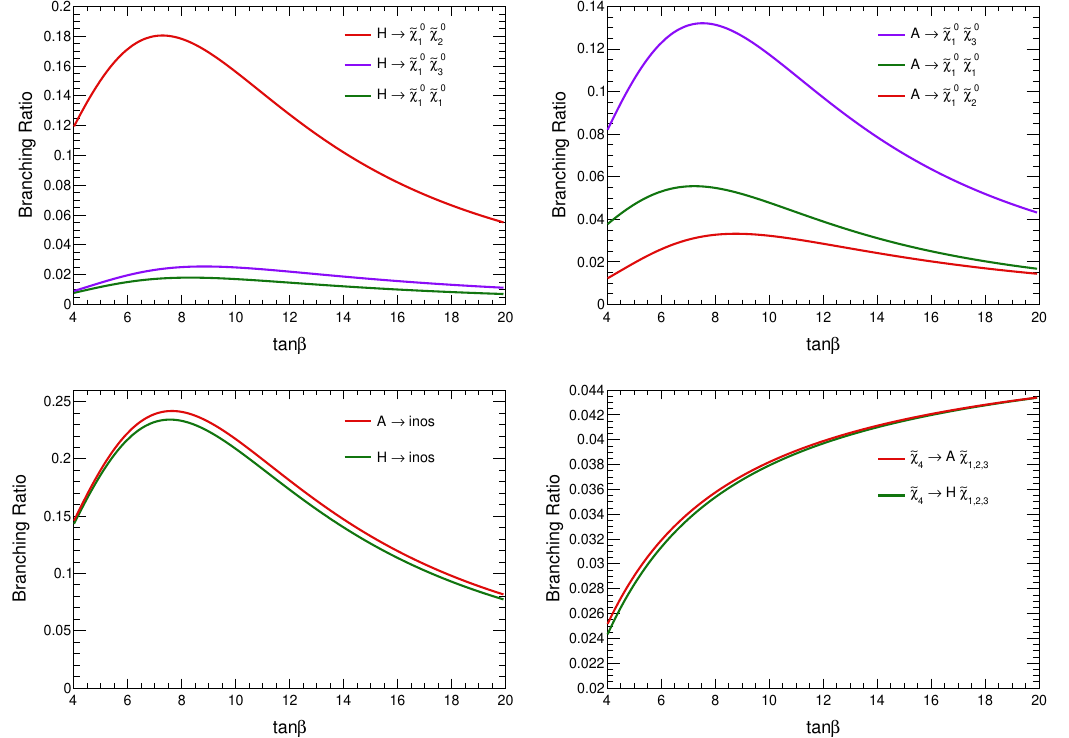
Figure 1. Dominant branching ratios for heavy CP-even and CP-odd Higgs decays to individual electroweakino modes (top panel), the total branching ratio for two heavy Higgs (bottom left), branching ratio of heaviest neutralino decays to heavy Higgs (bottom right) for the case-1a. The wino, bino, higgsino mass parameters M 2 , M 1 , µ are fixed at 1500, 450 and 370 GeV and tan β is